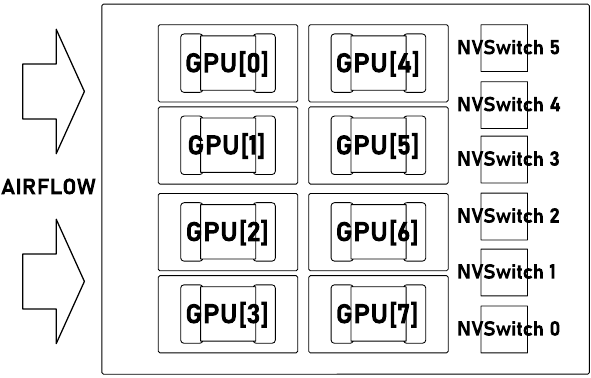
Figure 2. Physical GPU layout of the DGX-A100 server [5].